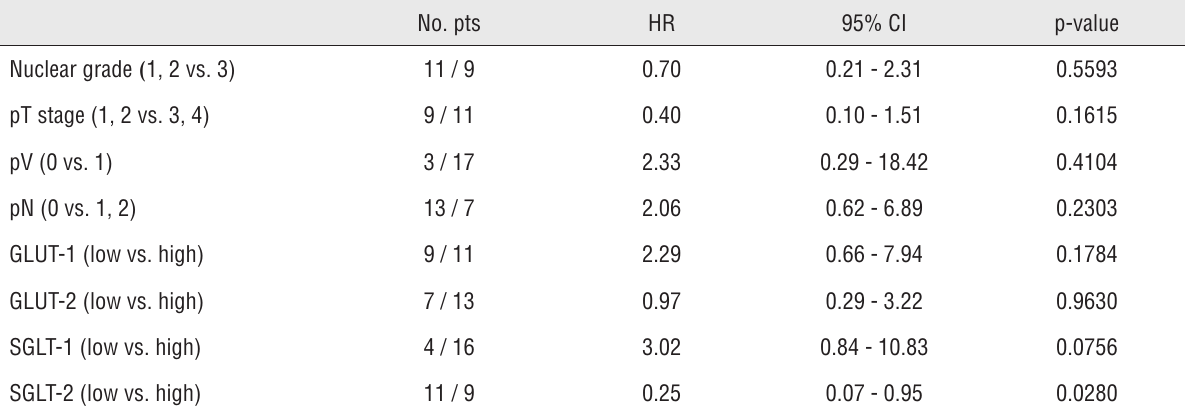
Table 4 - Univariate analysis for various potential prognostic factors in overall survival in metastatic diseases. No. pts HR 95% CI Nuclear grade ( 1, 2 vs. 3)